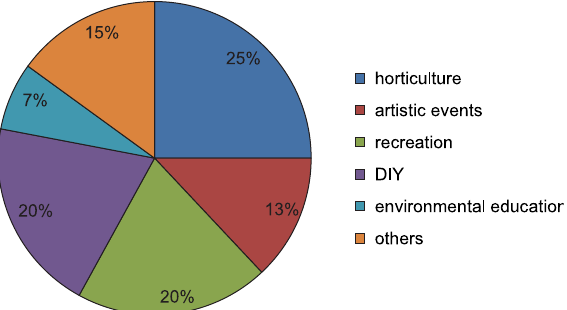
Fig. 7. Types of events in the ‘Bathing Beach’ Collective in Poznań in the years